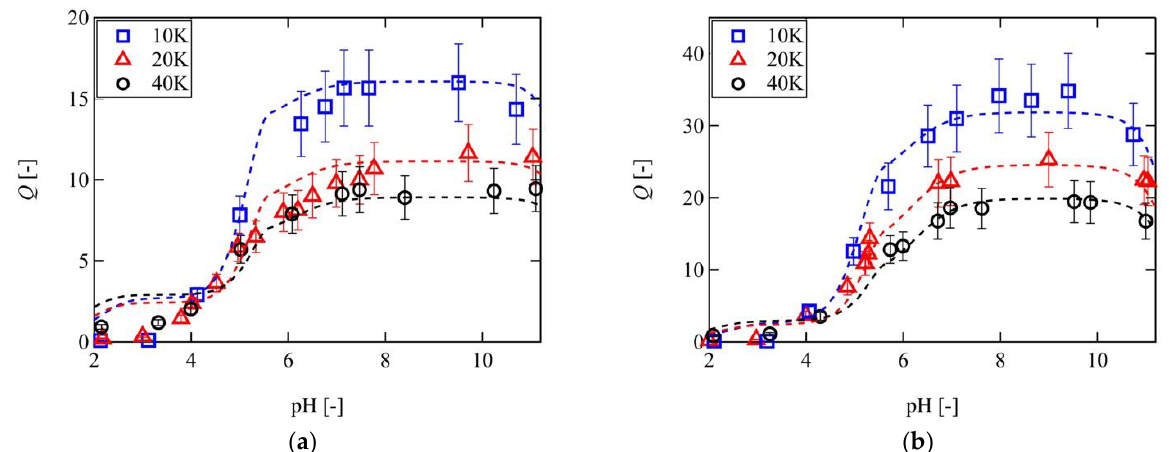
Figure 8. Comparison of the experimental results with the predictions made by the FRGDM model, adopting the Gent model to describe the elastic free energy (dashed lines) for the 10 K (blue), 20 K (blue), and 40 K (black) Tetra-PAA-PEG gels at ionic strengths of ( a ) 10 mM and ( b ) 2 mM.